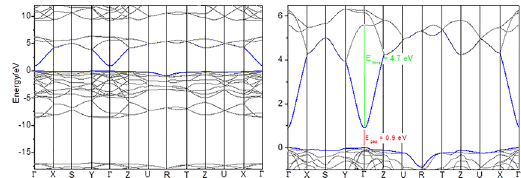
, with the energy scale set so 2